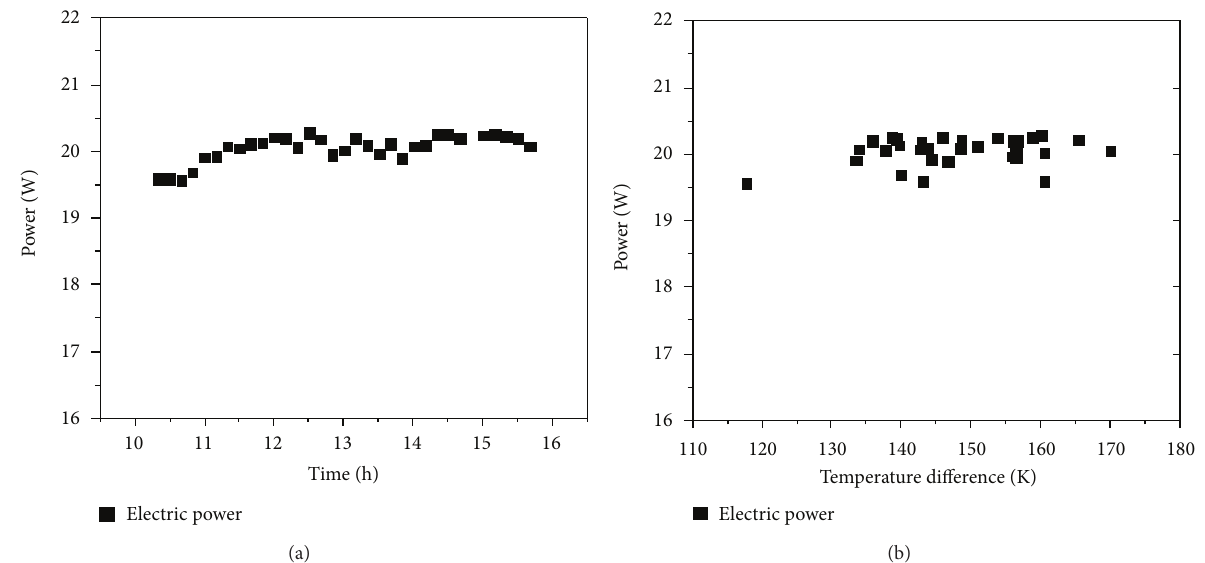
Figure 6: Electric power generation as a function of time of day (a) and as a function of the temperature difference between the TEG plates (b).